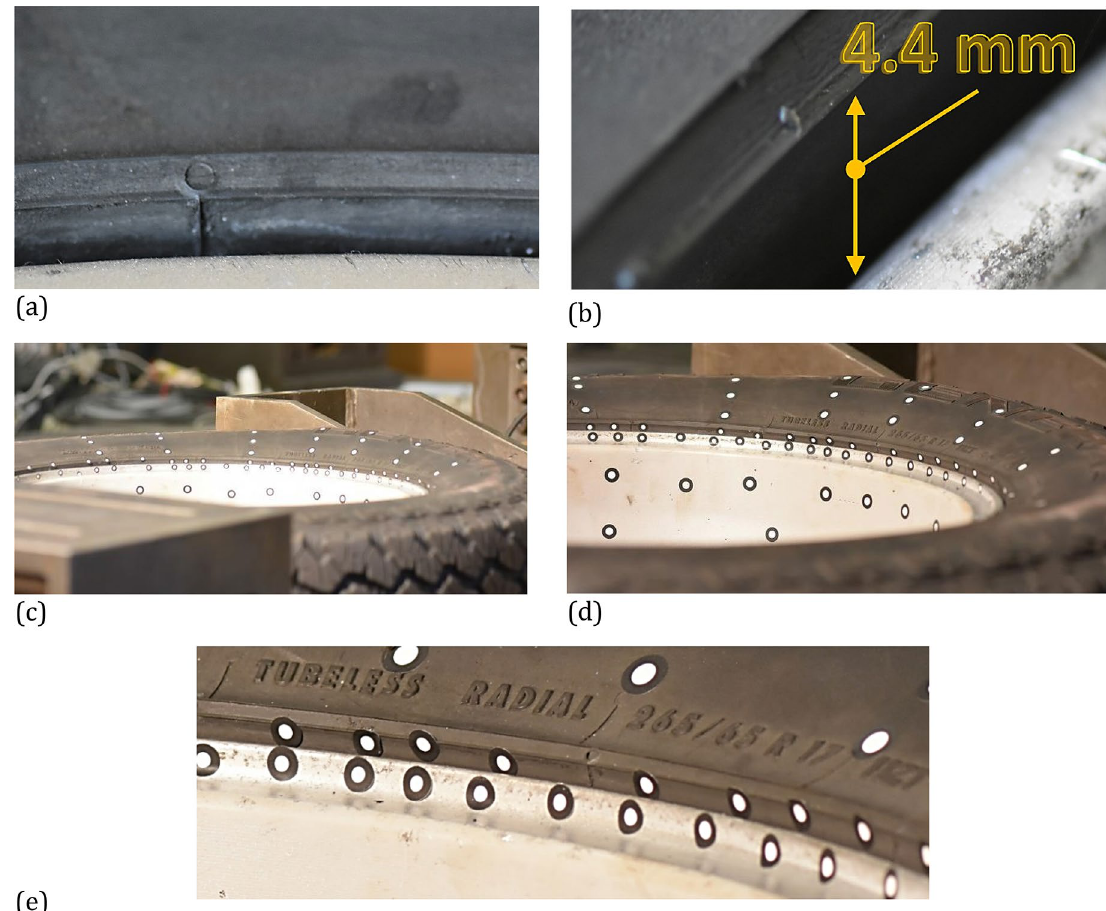
Figure 14. The wheel: ( a ) and ( b ) the tire guard and rim edge before loading; ( c ), (d), (e) under force of 11 kN: general view, magnified view of deflected tire and edge of the rim,